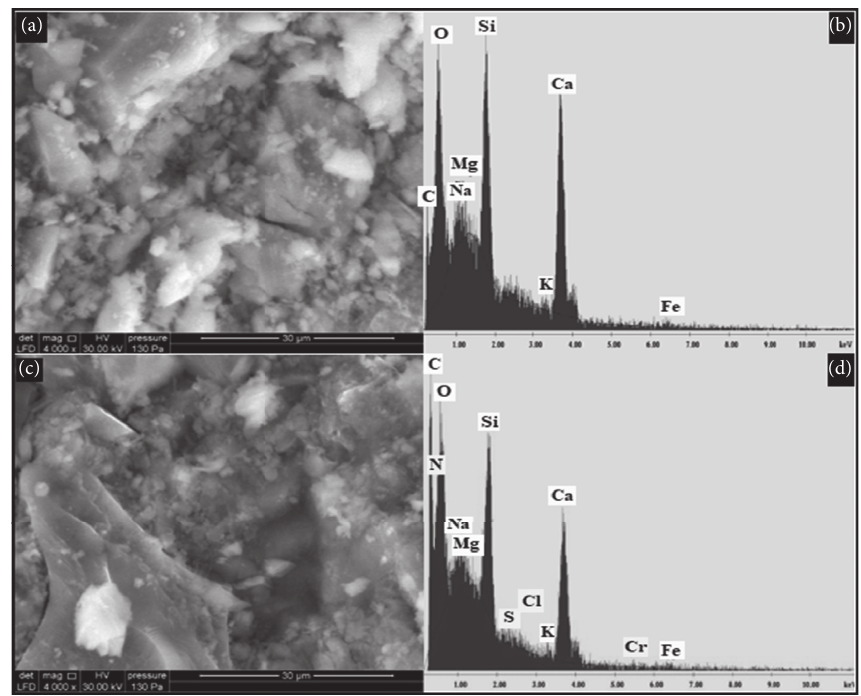
Figure 5: Morphological examination of natural sand (a, b) and loaded sand (c, d) by SEM-EDX. Table 3: Percentage of elements found by X-ray energy dispersion EDX in natural and loaded sand.